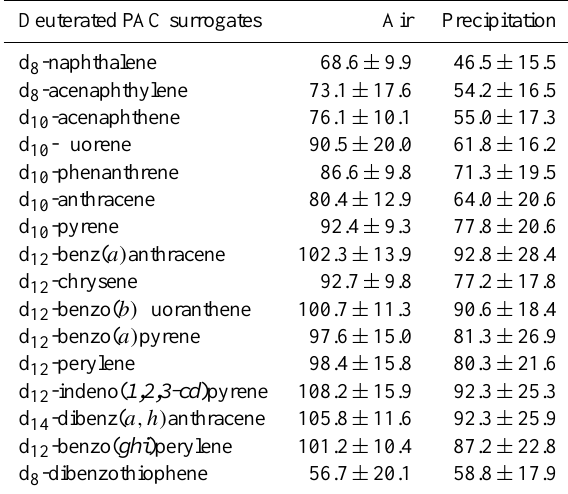
Table 1. Percent recoveries for deuterated PAC surrogates Deuterated PAC surrogates Air